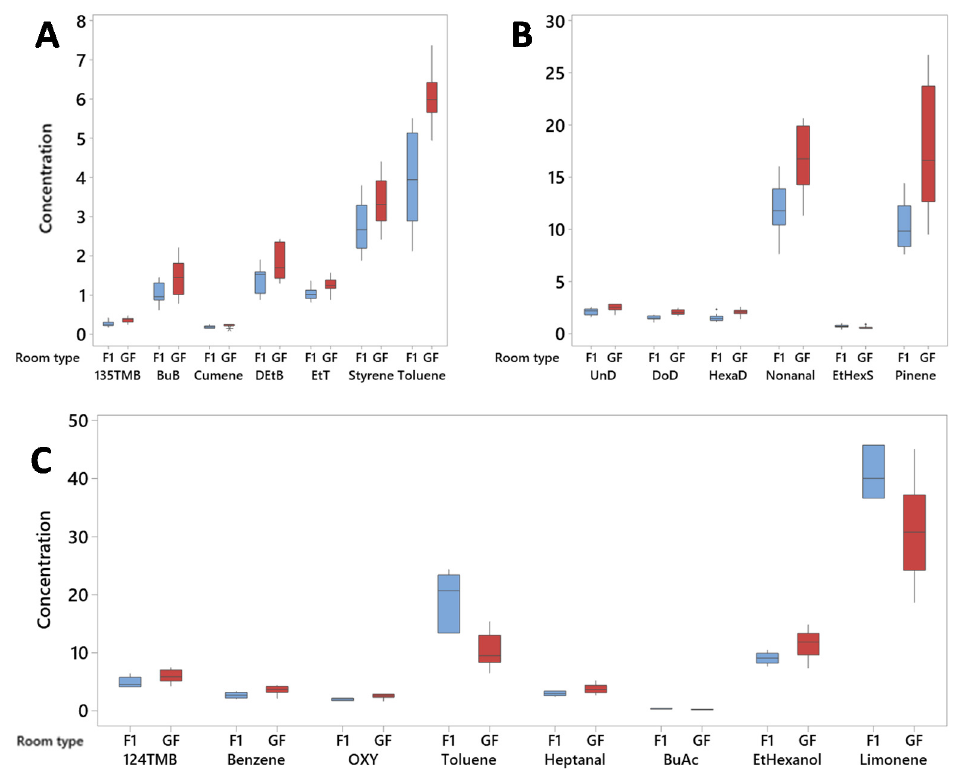
Figure 5. Comparison of VOC concentrations ( μ g/m 3 ) between ground floor and first floor class- rooms. ( A , B ) with n = 12 samples in S3, ( C ) with n = 6 and 12 samples for F1 and GF classrooms in S4, respectively.